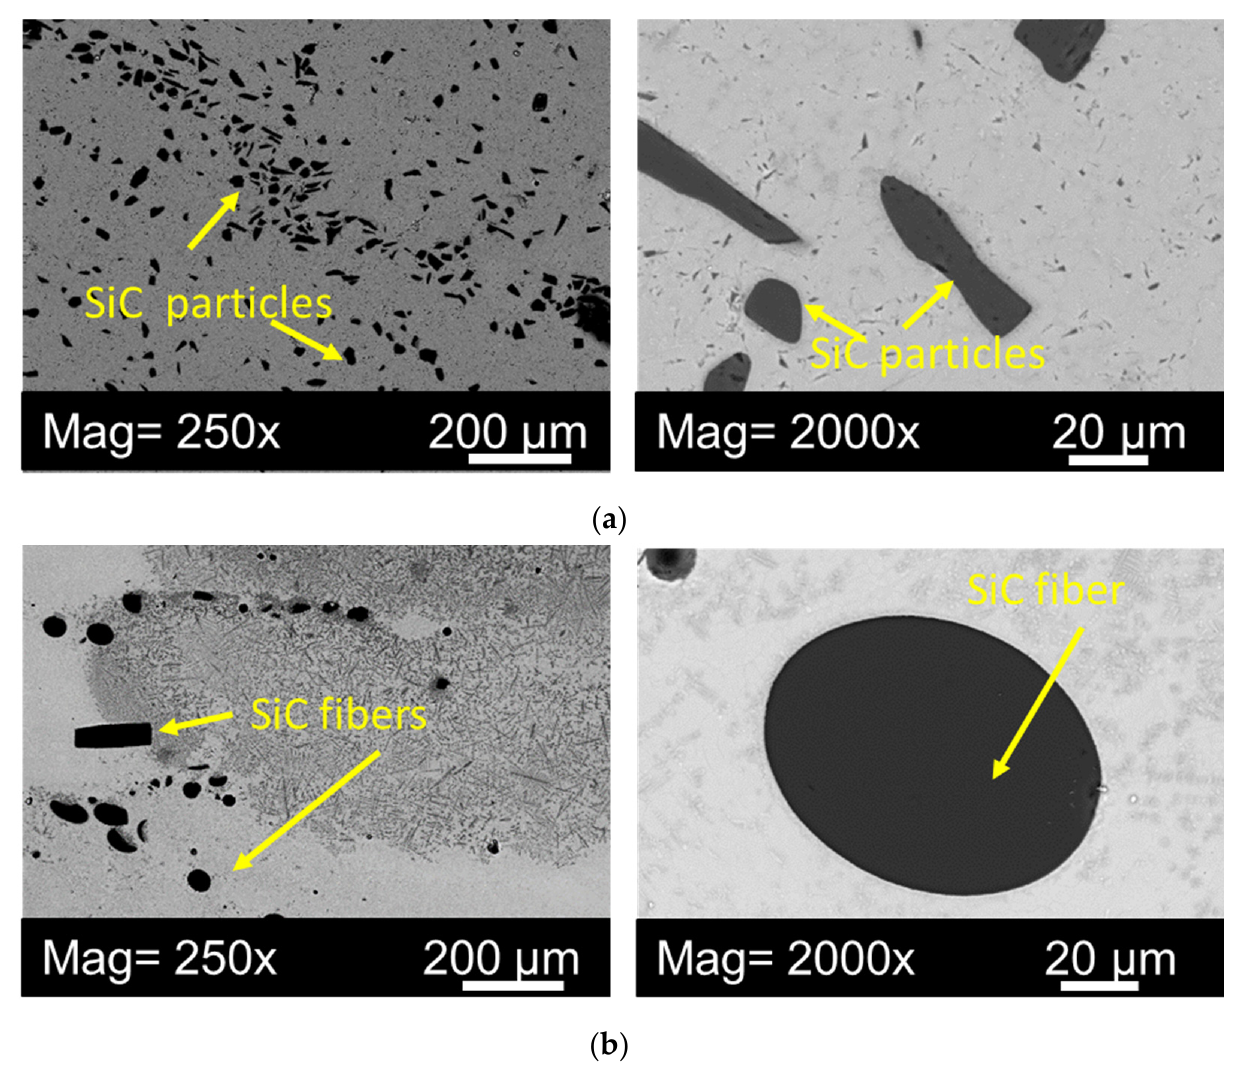
Figure 3. SEM image of a metal-matrix multilayer material (( a )-Ti64 + SiC ceramics (DMD), ( b )-Ti64 + SiC ceramic fibers (LSC).